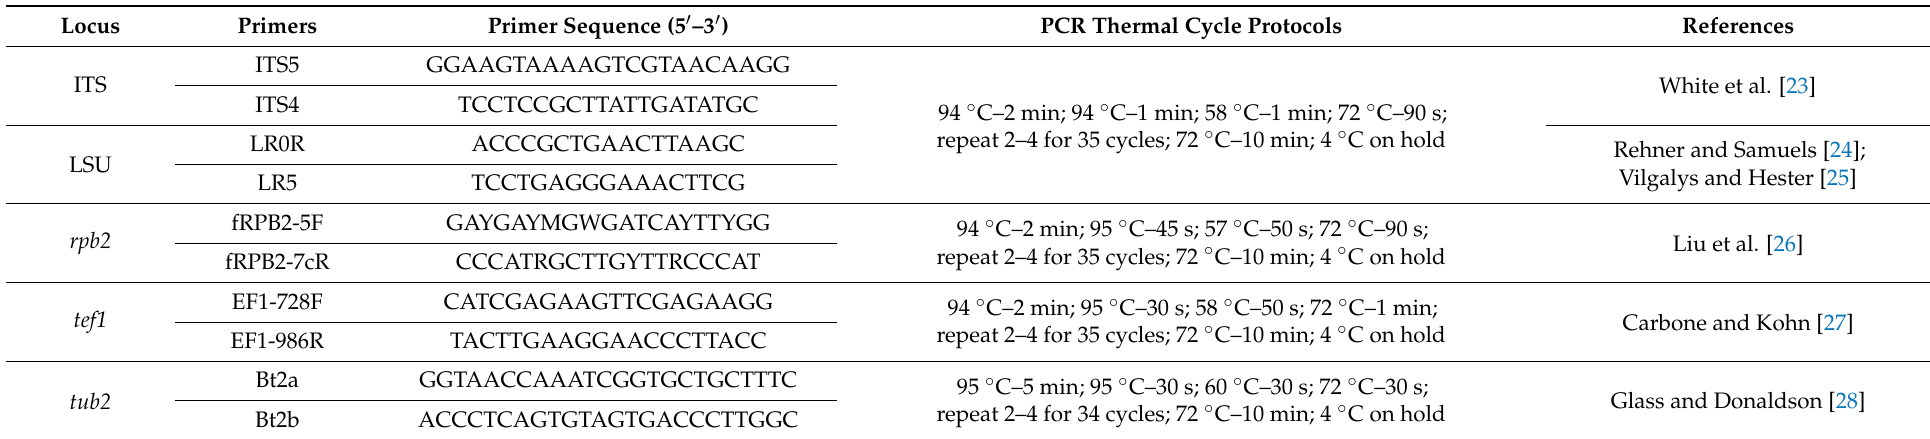
Table 1. Primers and PCR procedures used in this